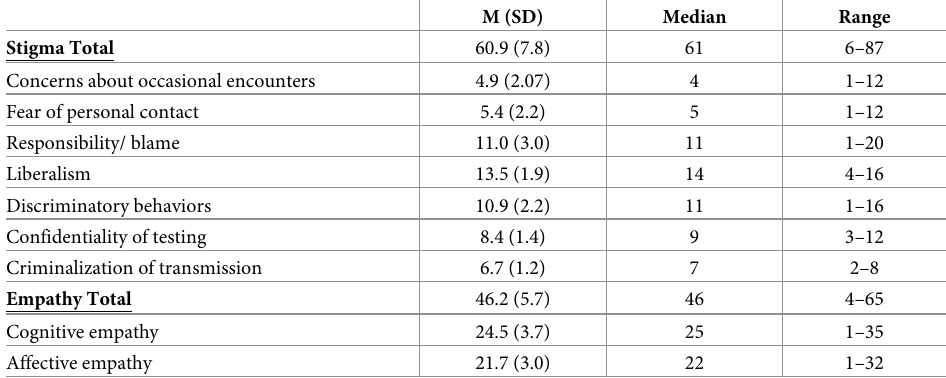
Table 2. Descriptive statistics of stigma and empathy total and subscales (N = 1074).